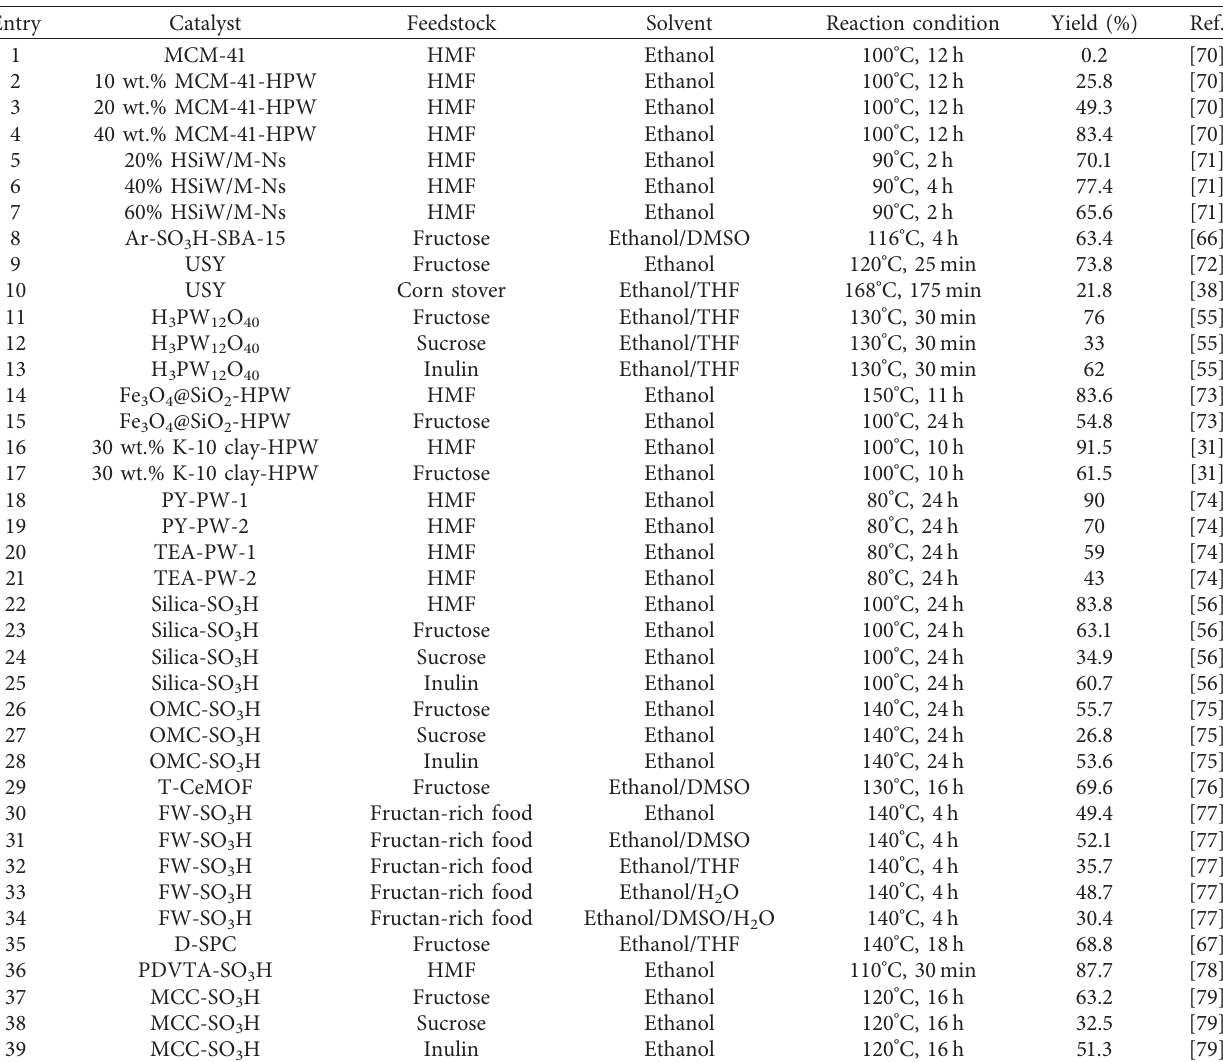
Table 3: Various heterogeneous catalysts used for EMF